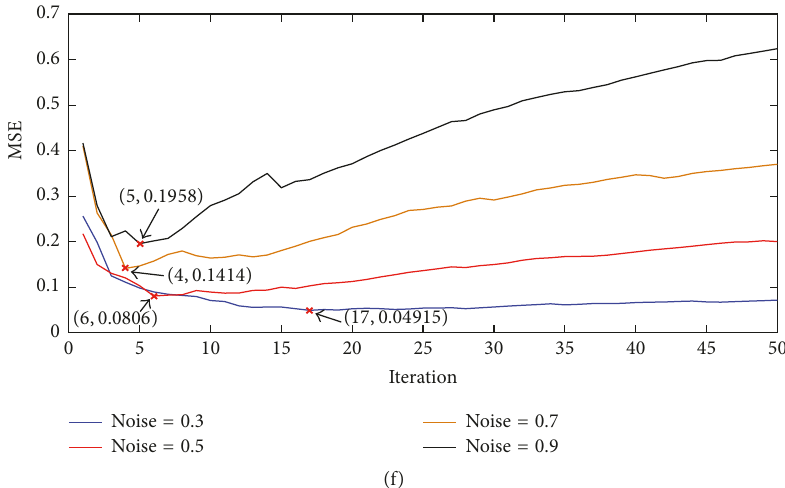
Figure 4: Simulated signal analysis results from the proposed method: (a) waveform of the optimum reconstructed signal under the noise amplitude of 0.3, (b) waveform of the optimum reconstructed signal under the noise amplitude of 0.5, (c) waveform of the optimum reconstructed signal under the noise amplitude of 0.7, (d) waveform of the optimum reconstructed signal under the noise amplitude of 0.9, (e) 𝐶 𝑚 is changed with the iterations, and (f) MSE is changed with the